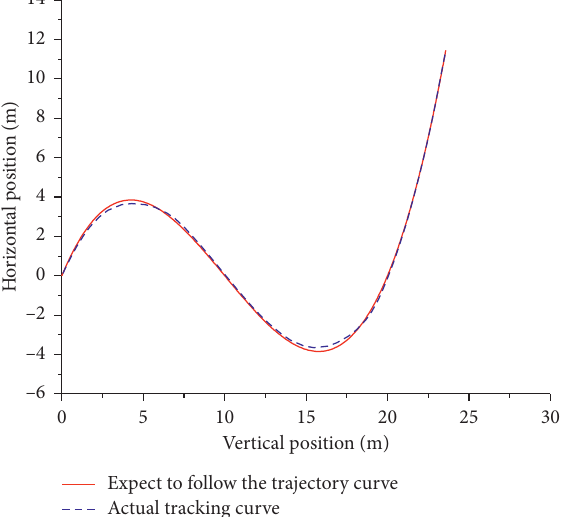
Figure 15: Position tracking simulation diagram.